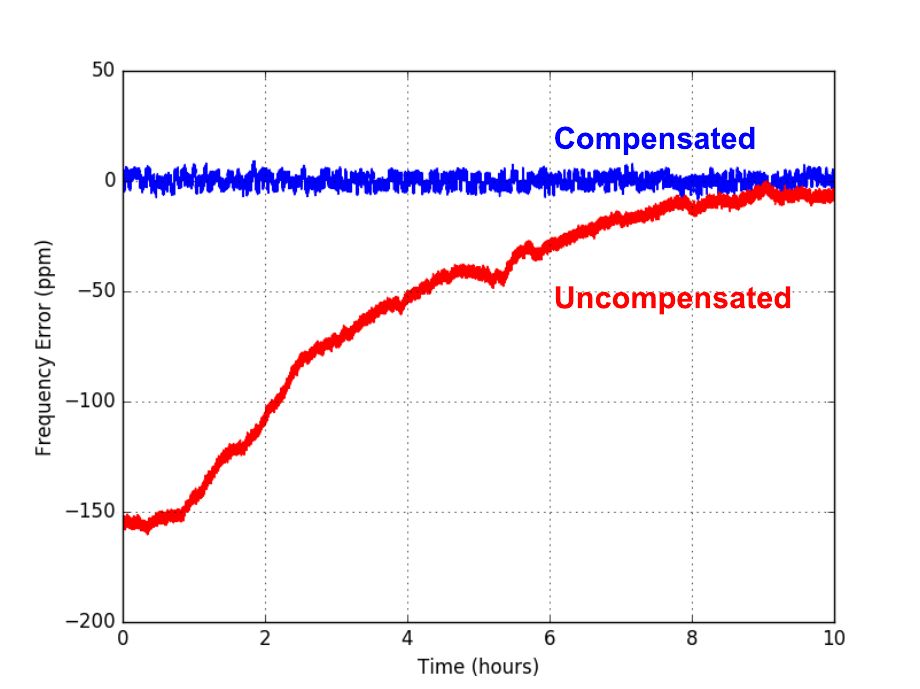
Figure 5. The LC oscillator frequency drift can be compensated through a feedback mechanism with incoming packets. With the feedback mechanism, the effect of the temperature variation is reduced from 150ppm (red trace) to less than 10ppm (blue trace) indoor, by testing over night [21]. The RFTimer is designed specifically for TSCH. It orchestrates the transition between the different states of the TSCH state machine, as shown in Figure 6. The RFTimer comes with multiple compare registers, which allows the entire sequence of events to happen during a slot to be programmed at the beginning of the slot. The RFTimer then works hand-in-hand with the radio. For example, a frame can be loaded into the transmit buffer of the radio automatically at a specific time, without needing code to be executed on the